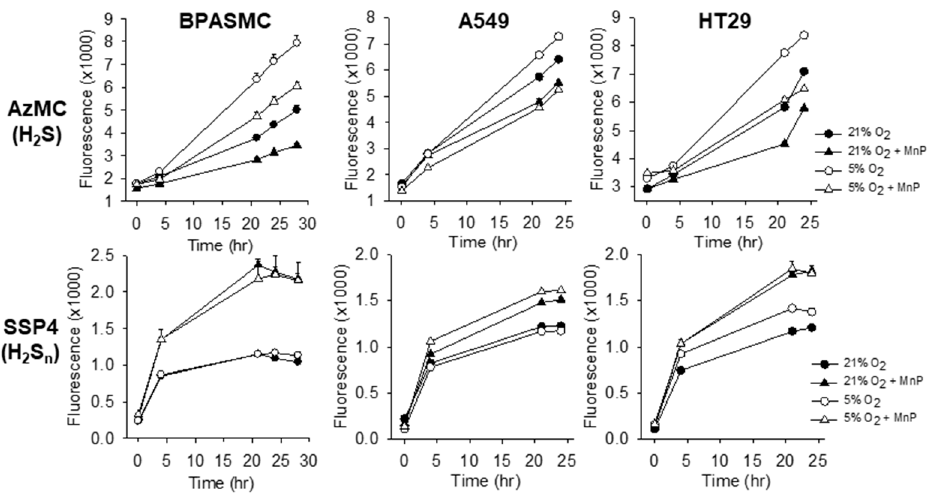
Figure 5. Effects of 1 μ M MnTE on cellular H 2 S (AzMC) and polysulfide (H 2 S n ; SSP4) in bovine pulmonary artery smooth muscle cells (BPMASMC), A549 and HT29 cells in hyperoxia (21% O 2 , solid symbols) and physioxia (5% O 2 , open symbols). Intracellular H 2 S was increased ( p < 0.01 ) in physioxic cells, whereas polysulfides were unaffected by O 2 tension. MnTE decreased cellular H 2 S and increased polysulfides in all cells ( p < 0.001 ). Mean +SE, n = 8 wells per treatment, error bars may be covered by symbols.